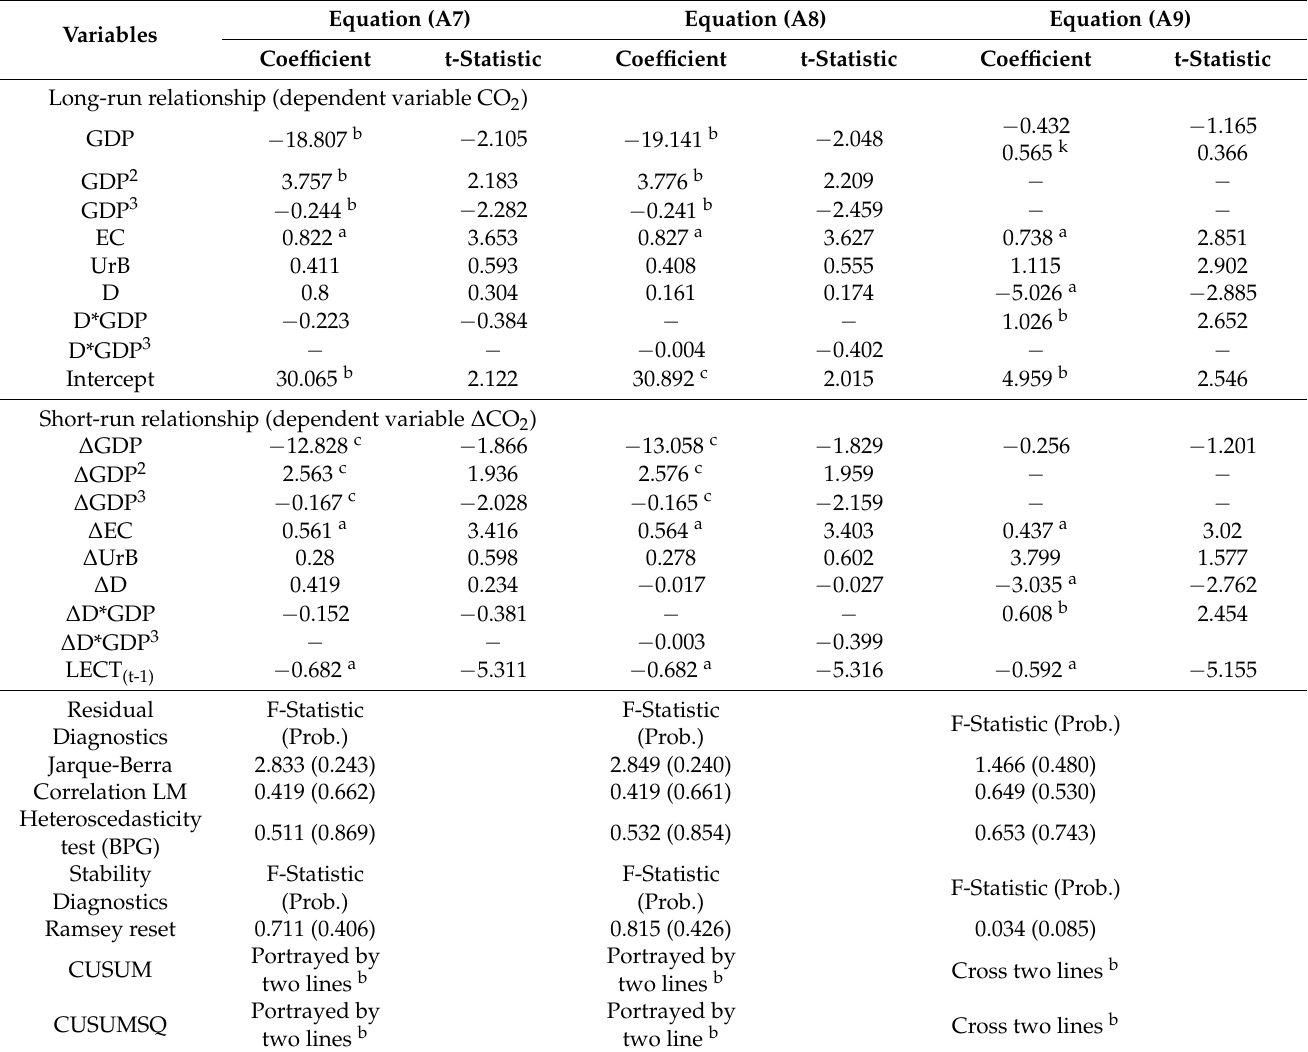
Table A8. The long- and short-run